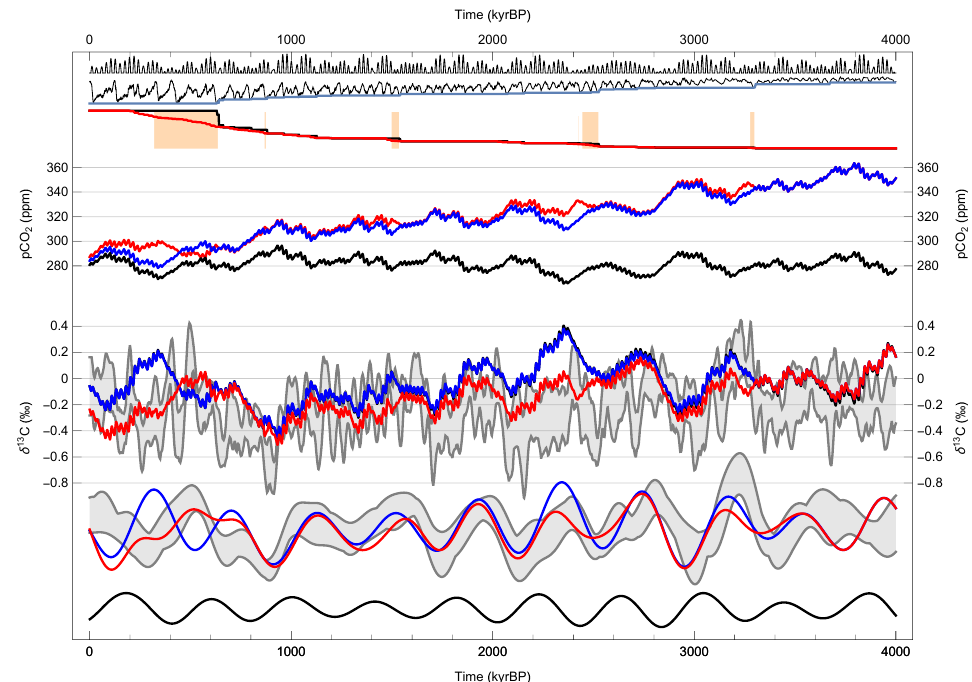
Figure 2. From top to bottom: precessional forcing F 0 ( t ) = Max(0 , − e sin ω ) (black line) from Laskar et al. (2004). Sea level curve LR04 (black line) from Lisiecki and Raymo (2005) used to compute the river incision z MIN defined as the previous sea level minima (blue line). The geomorphological variable s used from experiment c (red lines) relaxed to its prescribed maximum value s MAX ∼ z 3 The orange shaded areas correspond to the aggradation regimes (i.e. s < 0 . 85 s MAX ). Total carbon C rescaled as p CO 2 for experiments a (black, precessional forcing only), b (blue, similar experiment but with a linear trend in carbon), and c (red, using the geomorphological dynamics from Eq. 3). Carbon isotopic composition δ 13 C for experiments a (black), b (blue), and c (red). In grey, the min and max values of the 13 C records from Fig. 1. The 400kyr filtered values of δ 13 C results (blue and red) together with the range of filtered records (grey). The 400kyr filtered eccentricity as in Fig. 1. In order to obtain these results, we chose τ C = 200kyr (Archer et al., 1997) or equivalently V = 125TgCyr − 1 . The trend (experiments b and c ) is set to γ = 1 . 2TgCyr − 1 to induce a drift from about 350 to about 280ppm. The amplitude of the organic matter burial perturbation (experiments a,b and c ) is set to a = 50TgCyr − 1 . The filling rate of the sedimentary reservoir (experiment c ) is set to b = (160kyr) − 1 . The model is integrated from an arbitrary initial condition at 5MyrBP and the first 1Myr is